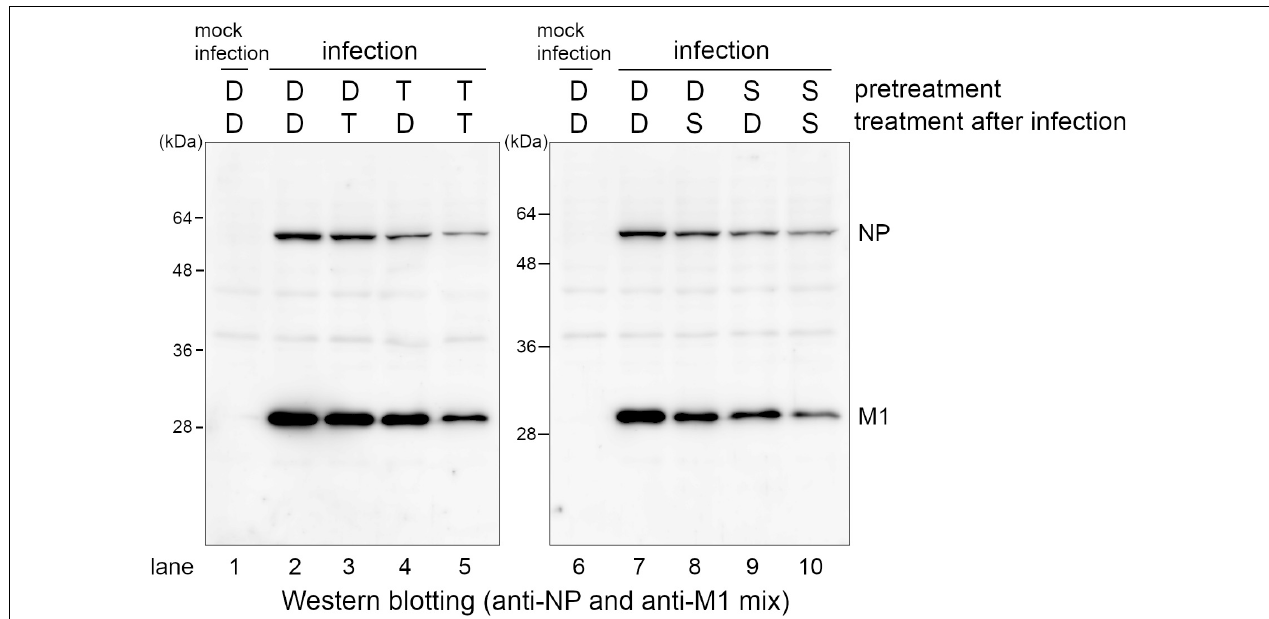
FIGURE 4 | Pre-treatment of SMeFM enhances the inhibitory effect of SMeFM on viral protein synthesis. MDCK cells were pretreated with 3 µ M of T-705 or 1 µ M of SMeFM for 24 h. The pretreated cells were infected with the influenza A virus (WSN strain) at an MOI of 1. The cells were collected and lysed at 8 hpi, and NP and M1 were detected by western blotting. D: DMSO, T: T-705, S: